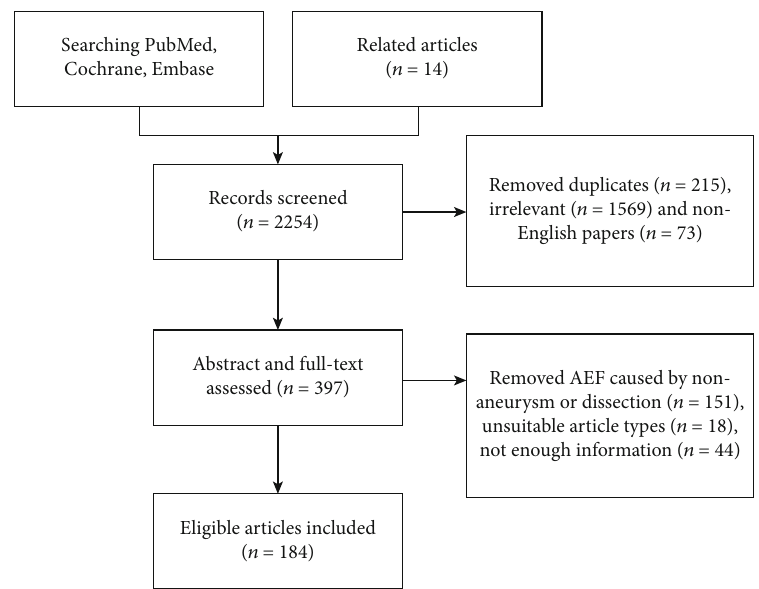
Figure 1: PRISMA fl